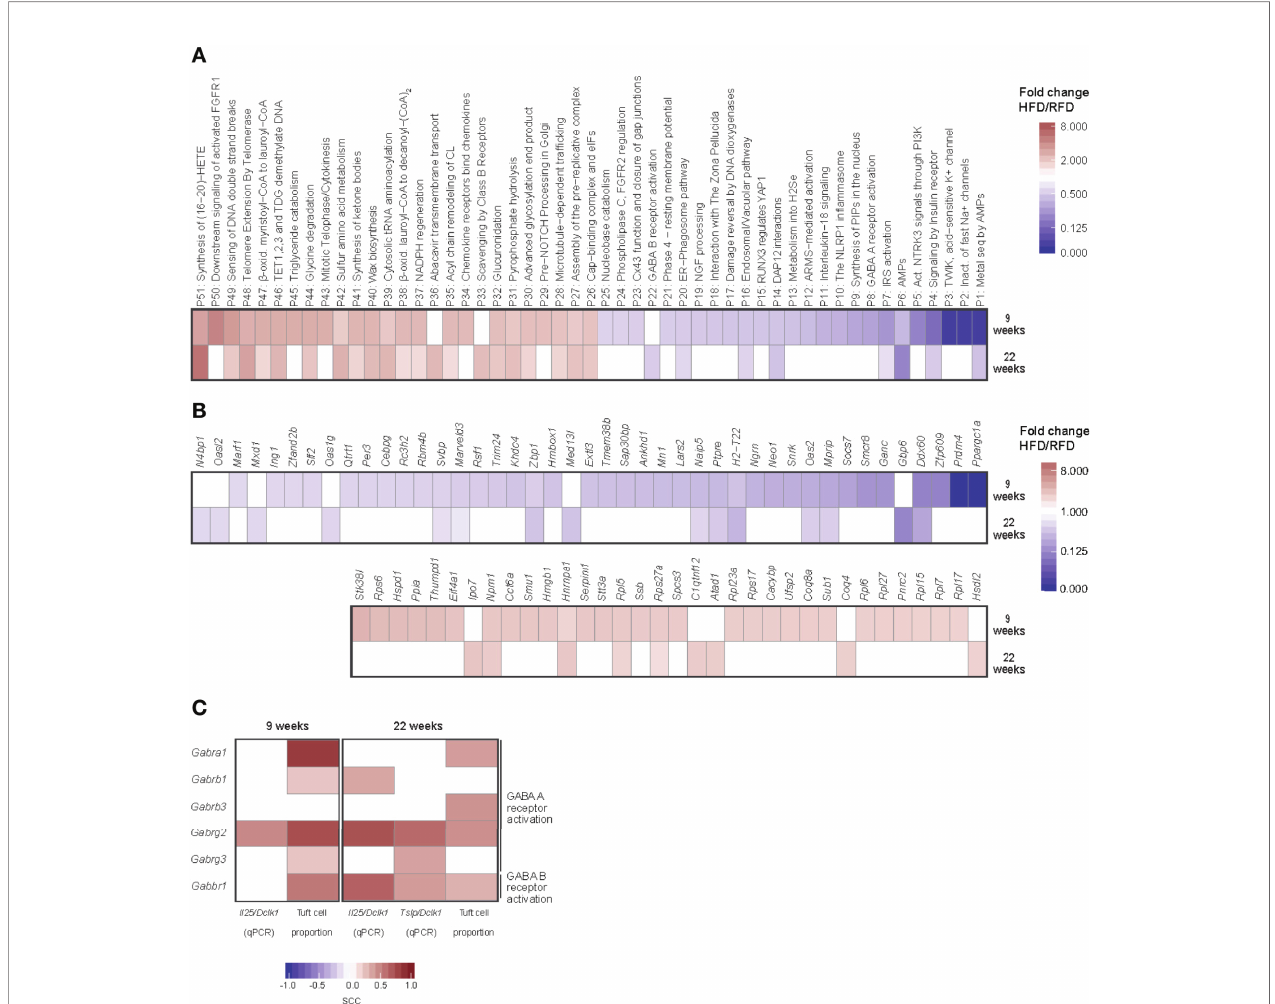
FIGURE 2 | Induction of distinct transcriptional changes in small intestinal tuft cells during diet-induced obesity development. RNA-seq-based transcriptional pro fi les of small intestinal tuft cells puri fi ed by FACS after 9 and 22 weeks of HFD or RFD feeding. (A) Signi fi cantly up- (red) or down-regulated (blue) pathways ( q- value < 0.05, fold change HFD/RFD > 2 or < 0.5), and (B) immune and/or metabolism relevant orphan genes, arranged by fold change. (C) Correlation analysis of expression levels of GABA receptor A and B encoding genes in tuft cells vs tuft cell numbers and expression levels of Il25 and Tslp (both relative to Dclk1 ). Spearman ’ s rank correlation was used for correlation analysis, with q -values < 0.1 considered statistically signi fi cant. The inserted color codes indicate the direction of the correlation (red: positive, blue: negative). N=10-12 per group, derived from three repeated experiments. SCC, Spearman correlation coef fi cient; RFD, reference fat diet; HFD, high fat